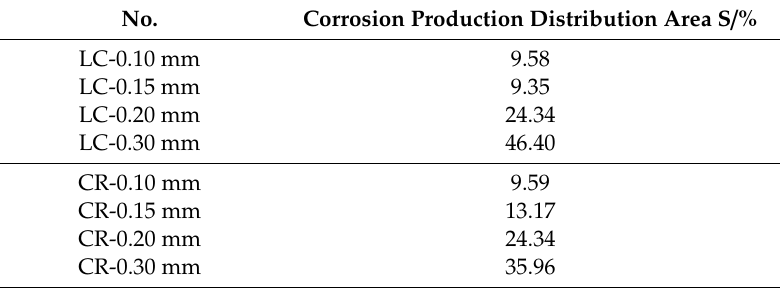
Table 7. Corrosion area S of different concretes (%).